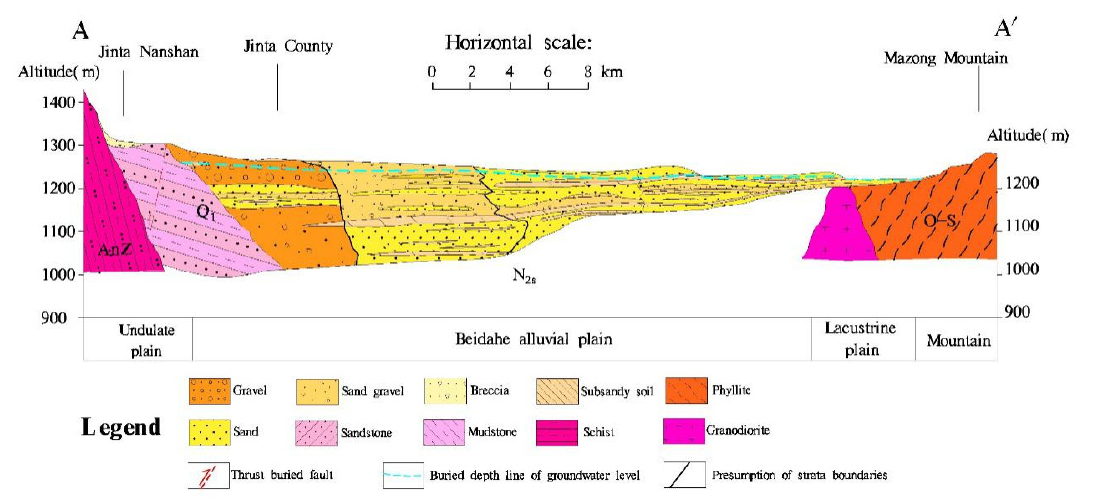
Figure 2. A – A ′ Hydrogeological profile of the Jinta Basin, China. Figure 2. A – A (cid:48) Hydrogeological profile of the Jinta Basin,